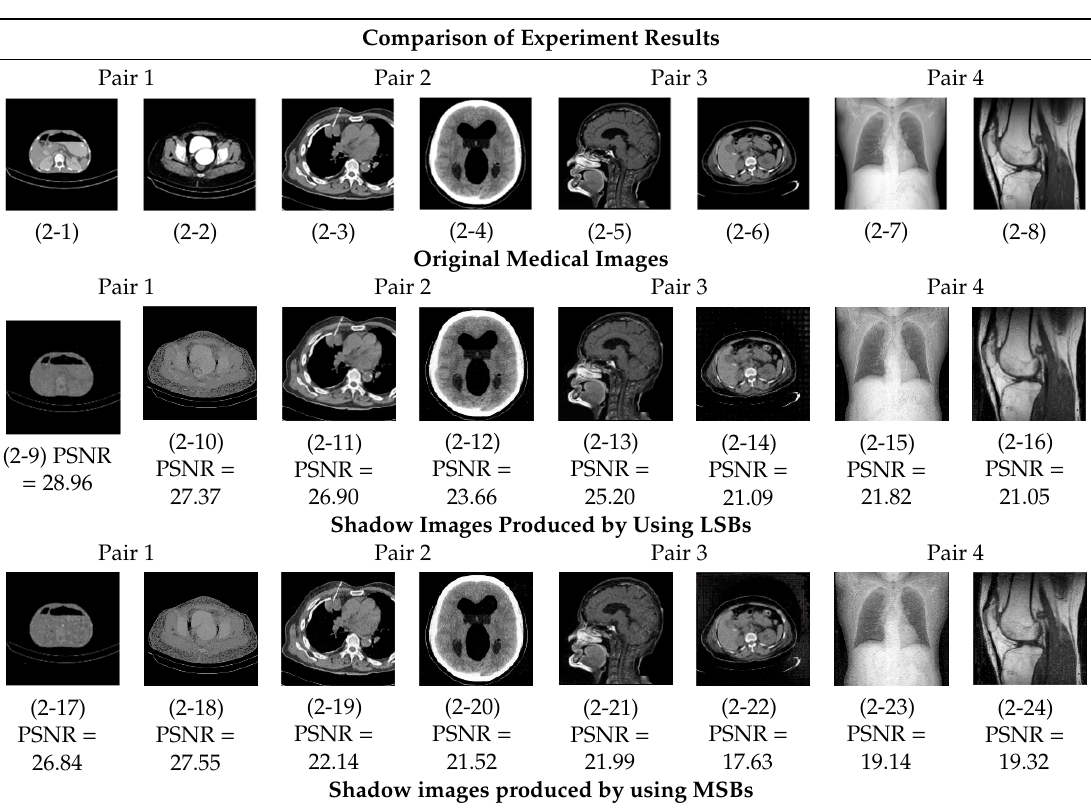
Table 2. Experimental result on medical images using (15,11) Hamming code.